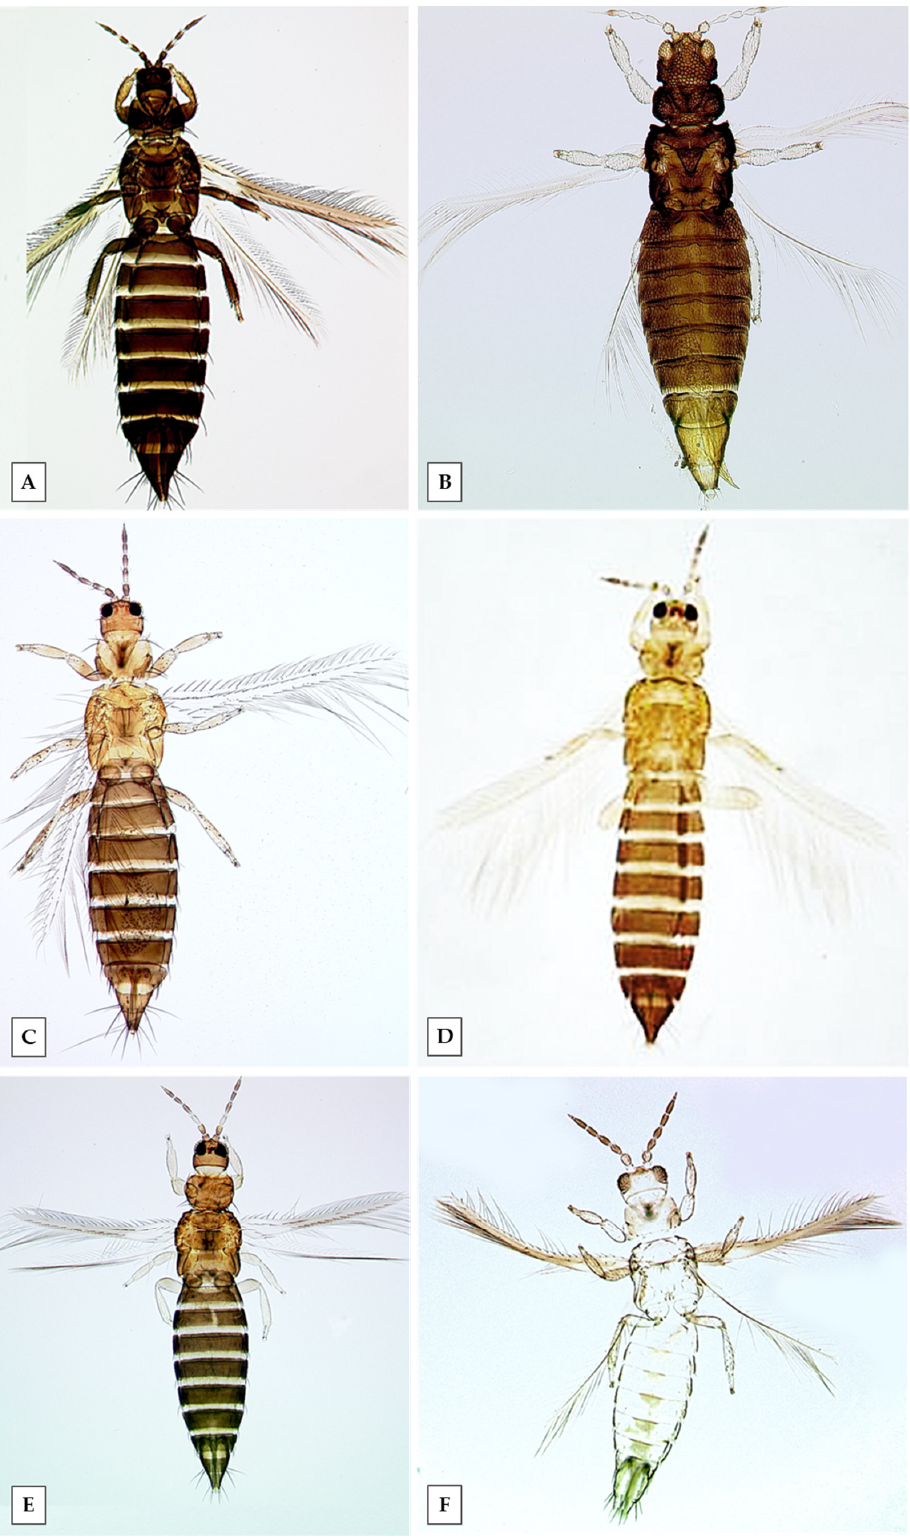
Figure 1. Adult females of Pezothrips kellyanus ( A ) *, Heliothrips haemorrhoidales ( B ) *, Frankliniella occidentalis ( C ) *, Thrips major ( D ) **, Thrips hawaiiensis ( E ) * and Scirtothrips dorsalis ( F ) * (* courtesy of Prof. Laurence A. Mound; ** courtesy of Dr. Allan H. Smith ‐ Pardo and Dr. Cheryle O’Donnell).